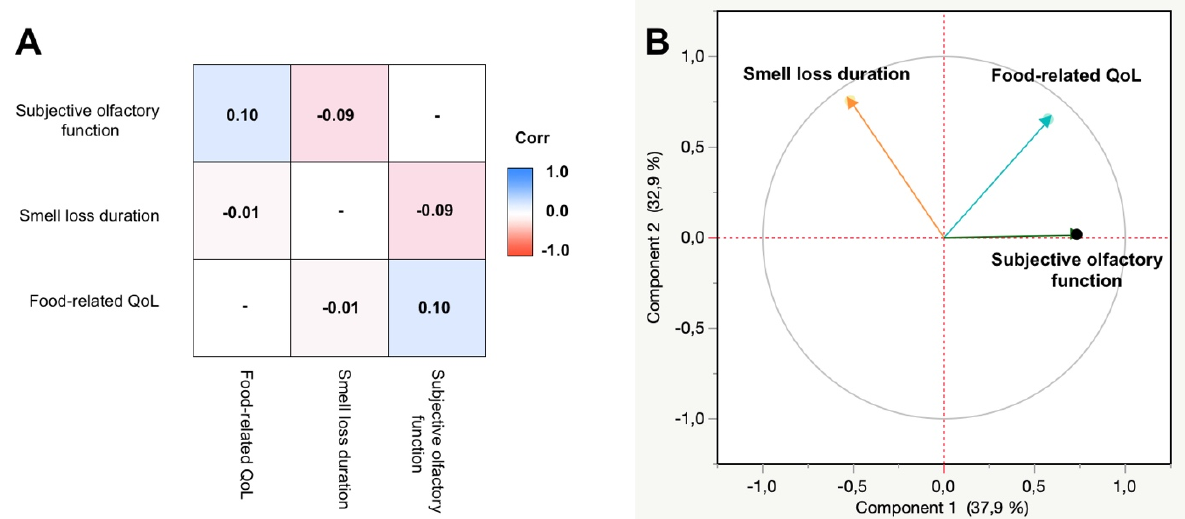
Figure 1. Correlations between the three principal components with respect to the food-related quality of life, duration of smell loss, and subjective olfactory function. ( A ) Correlation matrix. Shades of blue indica ate positive correlation, whereas shades of red indicate negative correlations. ( B ) Correlation circle of principal component analysis.